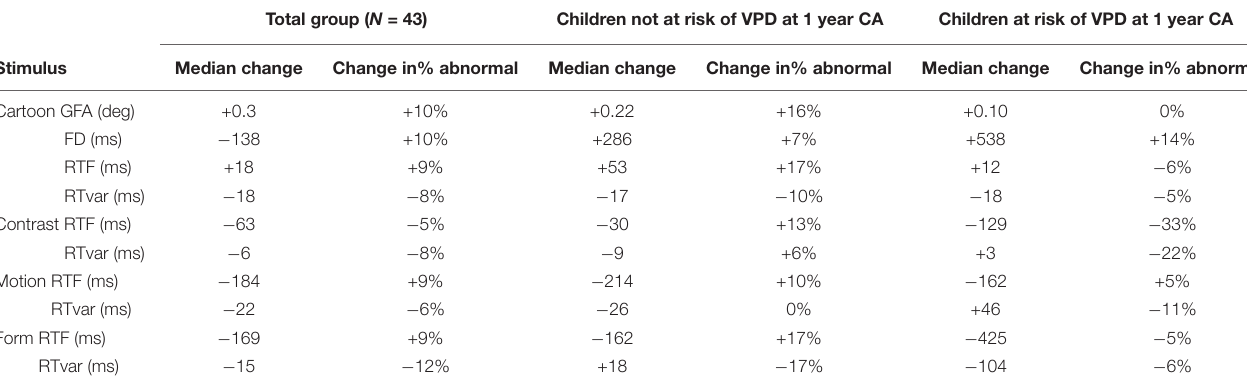
TABLE 7 | Median changes in stimulus-specific VOF parameters and changes in the percentage of abnormal parameter values compared to age-based normative references, separately for the total group, the children not at risk of VPD at 1 year CA and the children at risk of VPD at 1 year CA. Total group ( N = 43) Children not at risk of VPD at 1 year CA Children at risk of VPD at 1 year